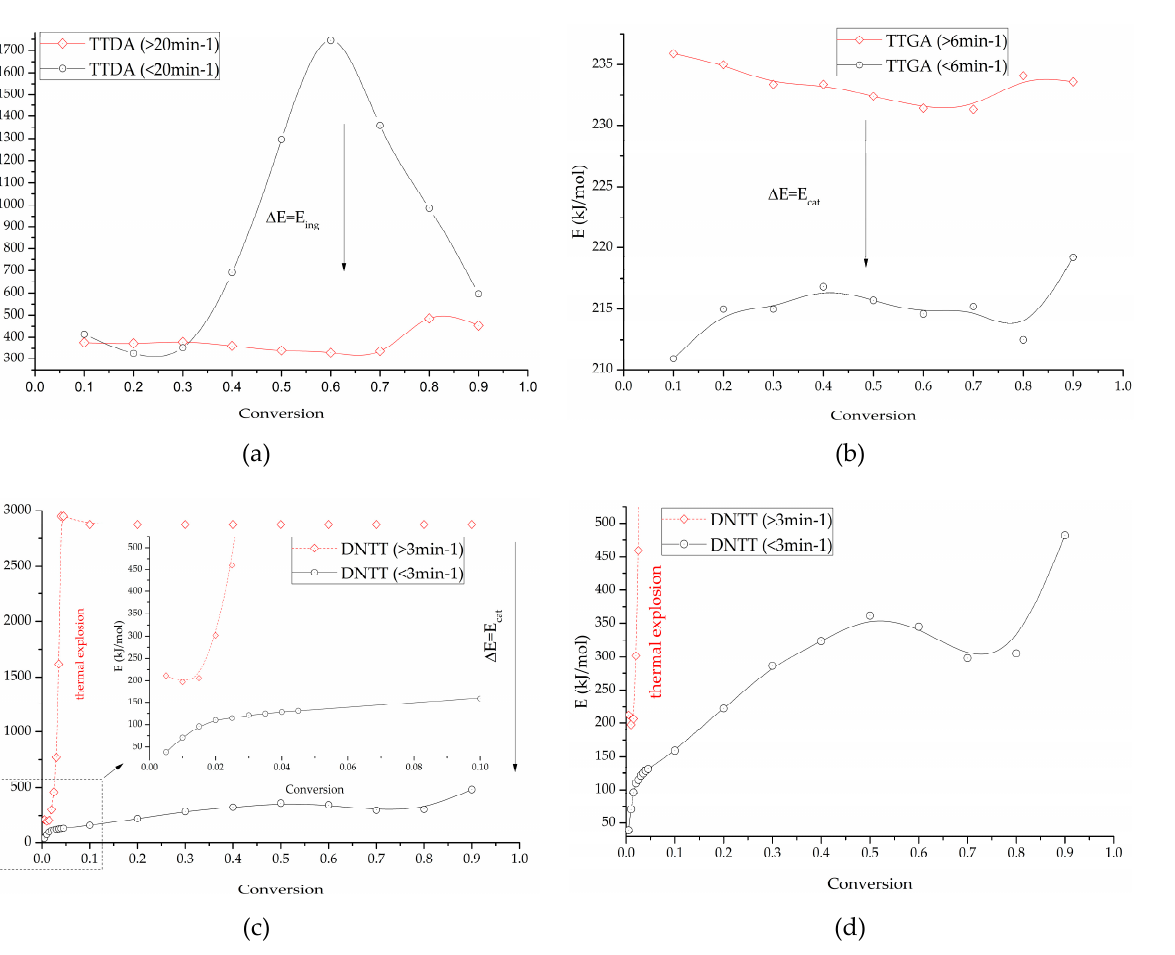
Figure 14 shows the inhibition and catalysis energies (autocatalysis) for the com- pounds under study, and Figure 15 shows the concentration-energy diagrams of reaction products obtained from calculations and experimental measurements for the compounds under study.